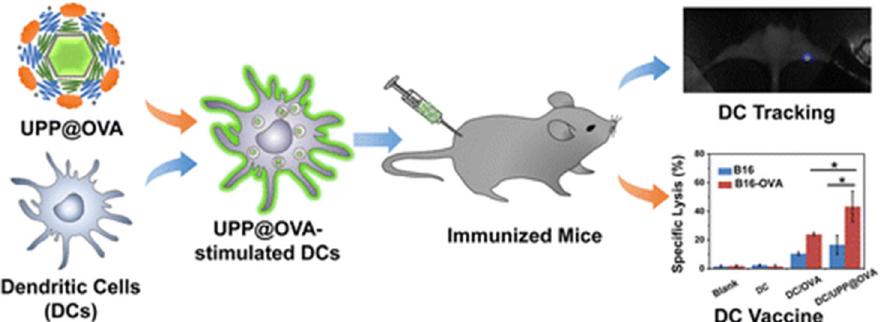
Figure 12. Schematic illustration of antigen-loaded UCNPs for dendritic cell stimulation, tracking, and vaccination in immunotherapy. Reprinted with permission from